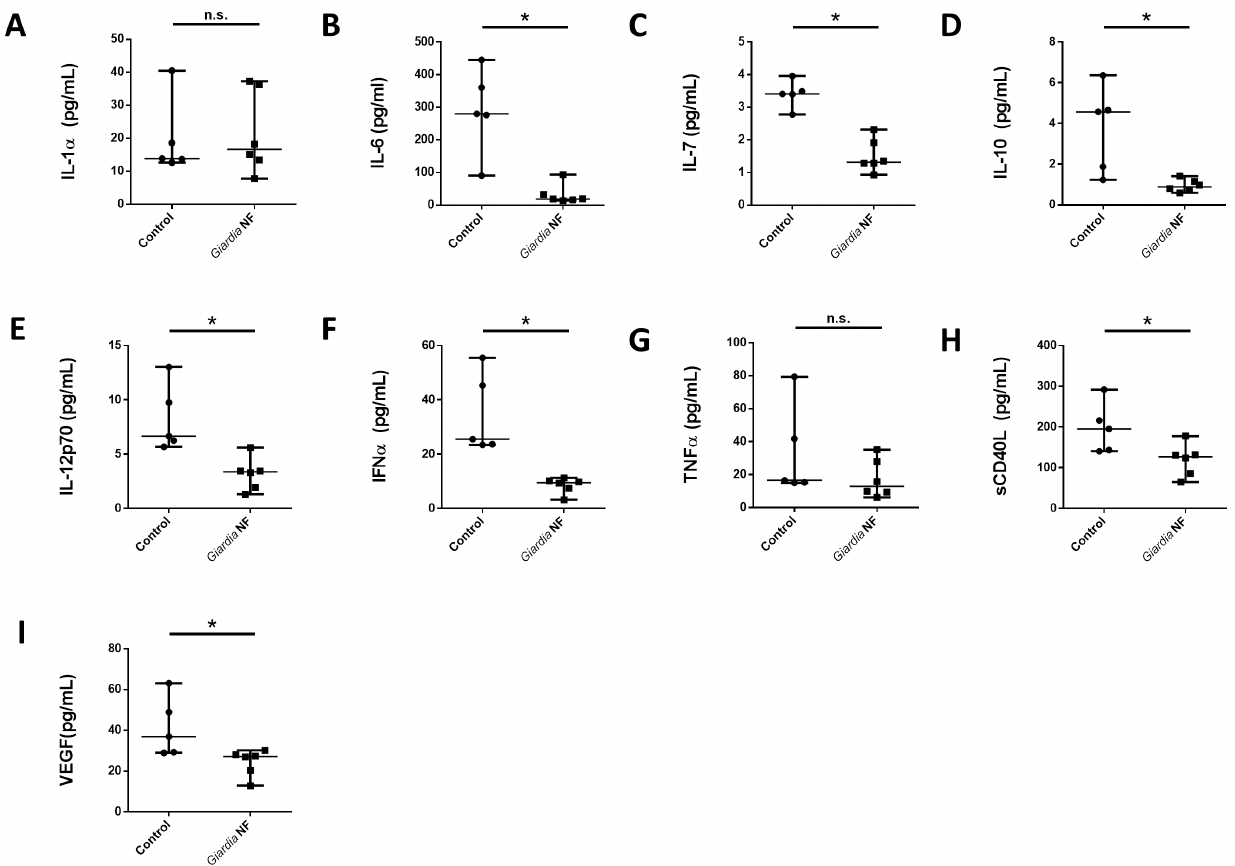
Figure 10. Giardia NF trophozoites attenuate the release of several pro-inflammatory mediators from colonic mucosal biopsies. Human descending colon mucosal biopsy tissues obtained from areas of active inflammation from patients with active Crohn’s disease (CD) were incubated with 5.0 6 10 6 Giardia NF trophozoites for 6 hours. Supernatant levels of (A) IL-1 a , (B) IL-6, (C) IL-7, (D) IL-10, (E) IL-12p70, (F) IFN a , (G) TNF a , (H) sCD40L, and (I) VEGF were determined via a bead-based cytokine assay. All data are representative of three independent experiments (n=4–6/ group) and represented as median with the range. * p , 0.05.